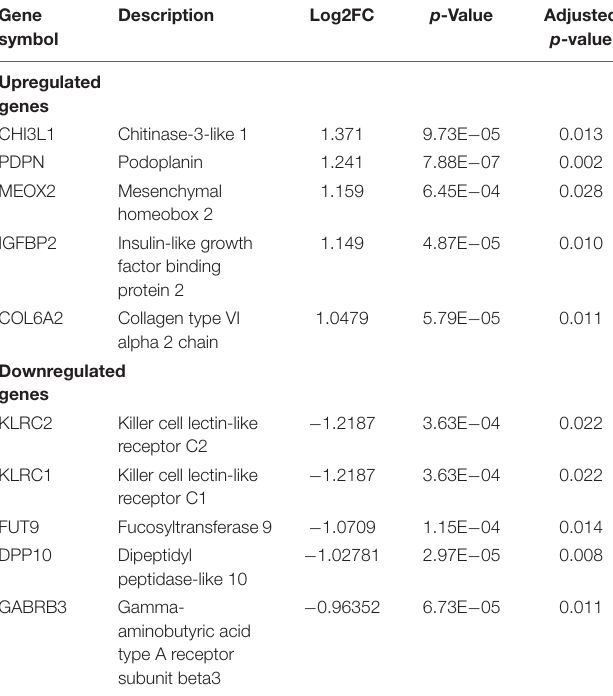
TABLE 1 | The list of the top five significantly upregulated and downregulated genes in STS identified in the GSE dataset.